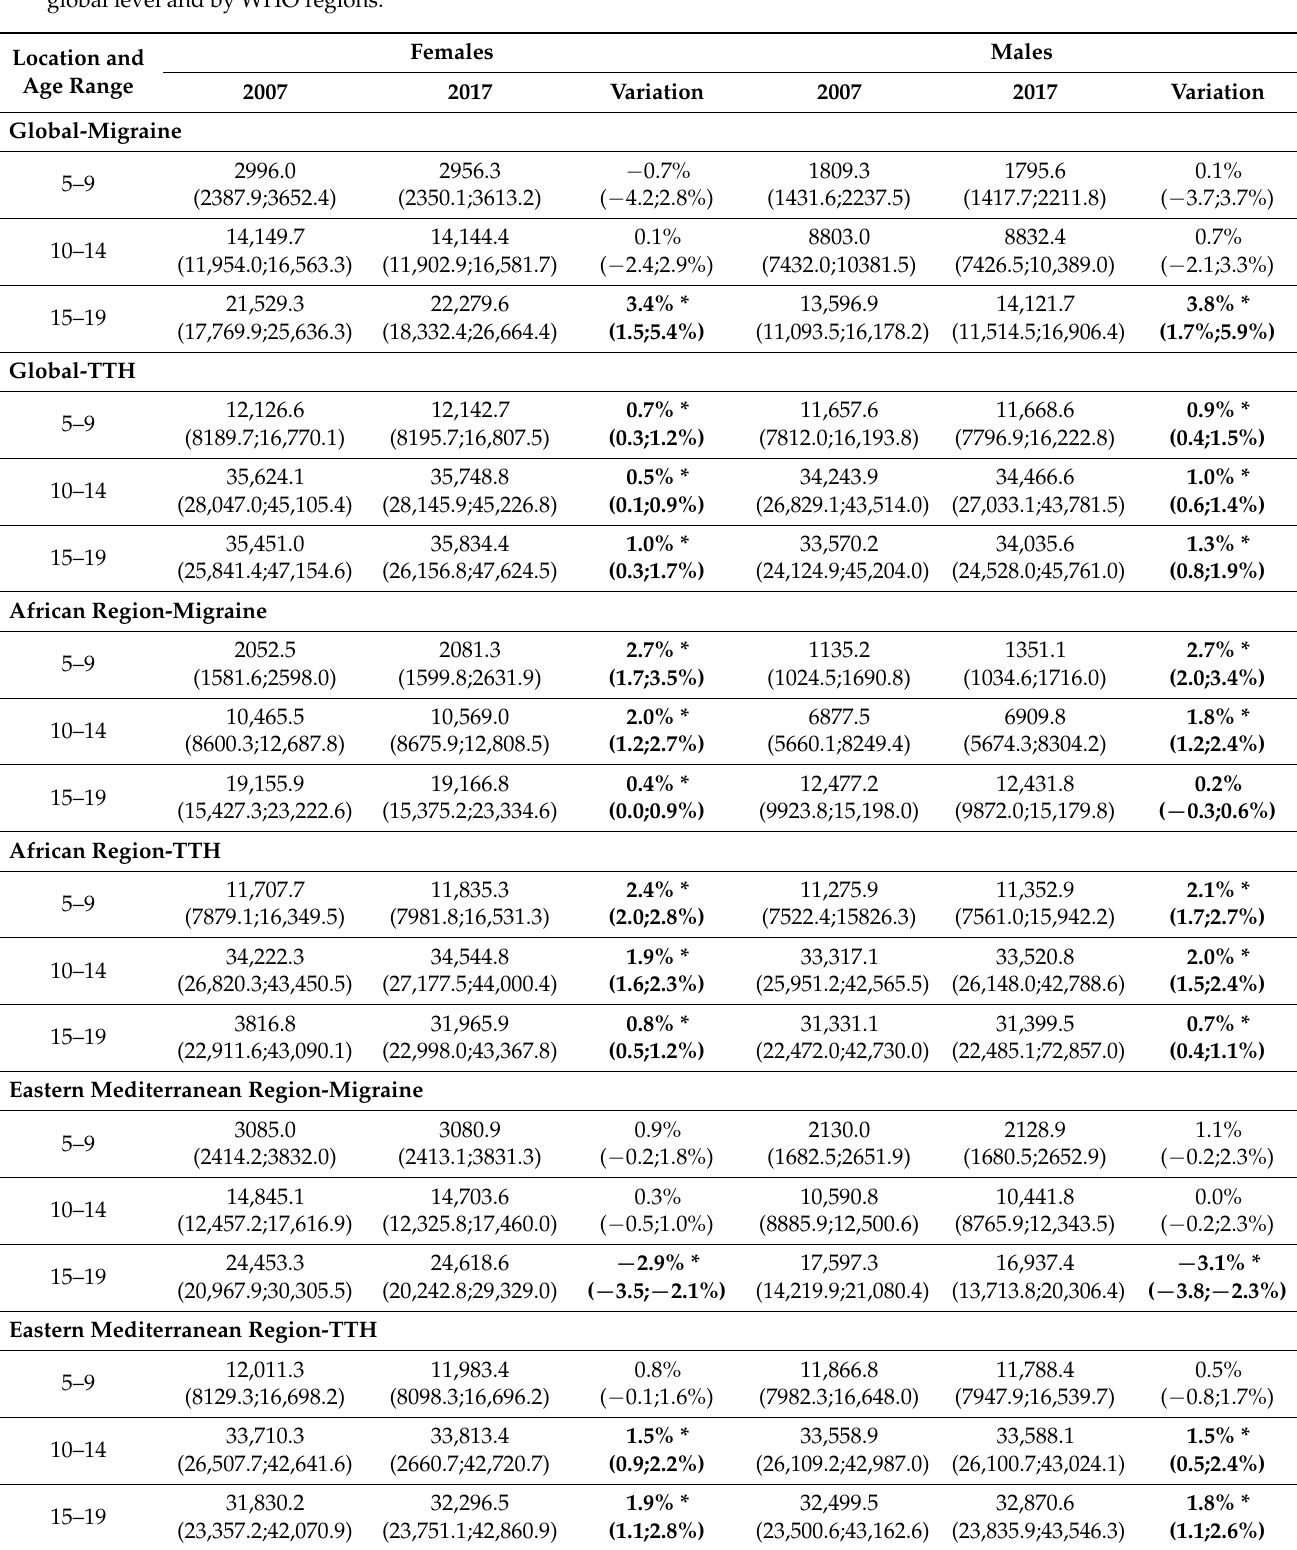
Table 1. Prevalence rates/100,000 for 2007 and 2017 and percentage variation, for migraine and TTH, by age and gender, at global level and by WHO